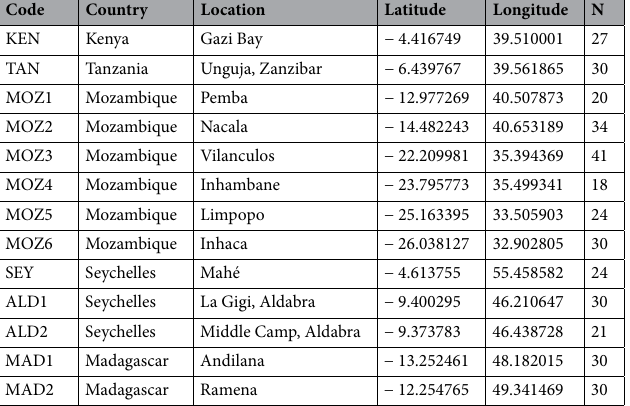
Table 1. Location details of 13 Rhizophora mucronata populations of the Western Indian Ocean (N = sample size).